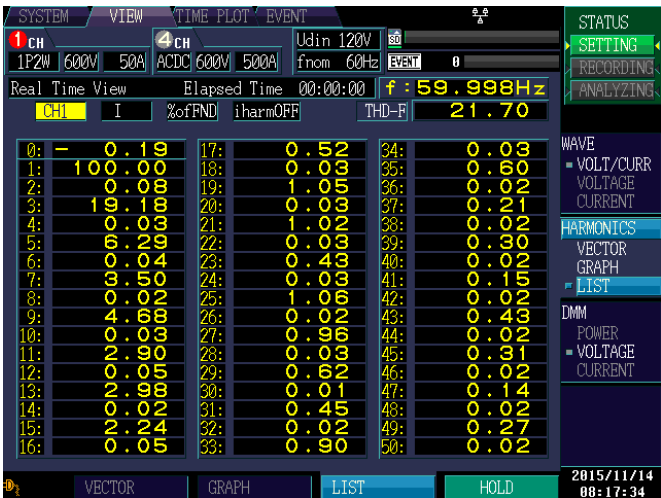
Figure 16. THDi obtained in experimental tests of the power quality meter.